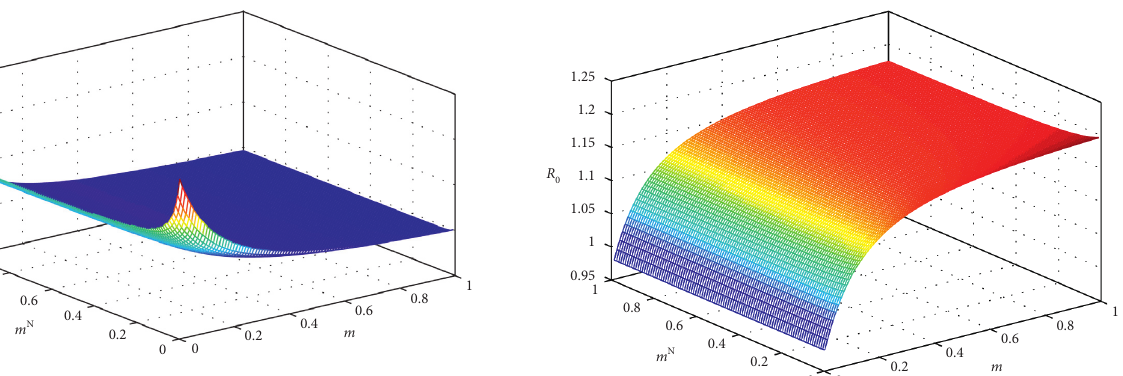
Figure 4: The effects of the diffusion rates on the net reproduction � 1 . 0667, R � 0 . 9257, K � 2 . 8, K � 3, Figure 7: The effects of the diffusion rates on the net reproduction number R where R 0 01 02 1 2 � 0 . 15, d N � 0 . 23, and m N , m J � m A � m vary from 0.01 to 1; d N � 0 . 96, R � 1 . 008, K � 2 . 8, K � 2 . 45, where R number R 1 2 0 01 02 1 2 all other parameters are given in equation d N � 0 . 18, d N � 0 . 14, and m N , m J � m A � m vary from 0.01 to 1; 1 2 all other parameters are given in equation (71).